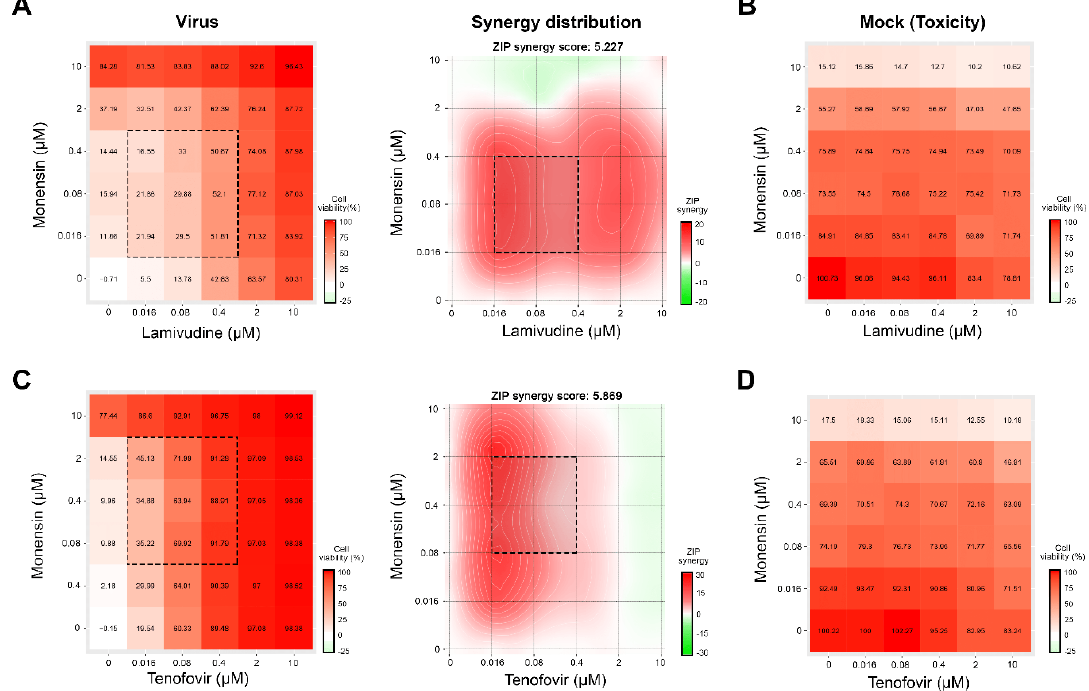
Figure 5. Combinations of monensin with lamivudine or tenofovir inhibit human immunodeficiency virus 1 (HIV-1)-mediated luciferase expression in TZM-bl cells. ( A , C ) The interaction drug combination landscapes measured as 6 × 6 dose-response matrices using an HIV-1 virus and reporter cell line expressing luciferase. ( B , D ) The interaction drug combination landscapes measured using and CTG assay on mock-infected cells.